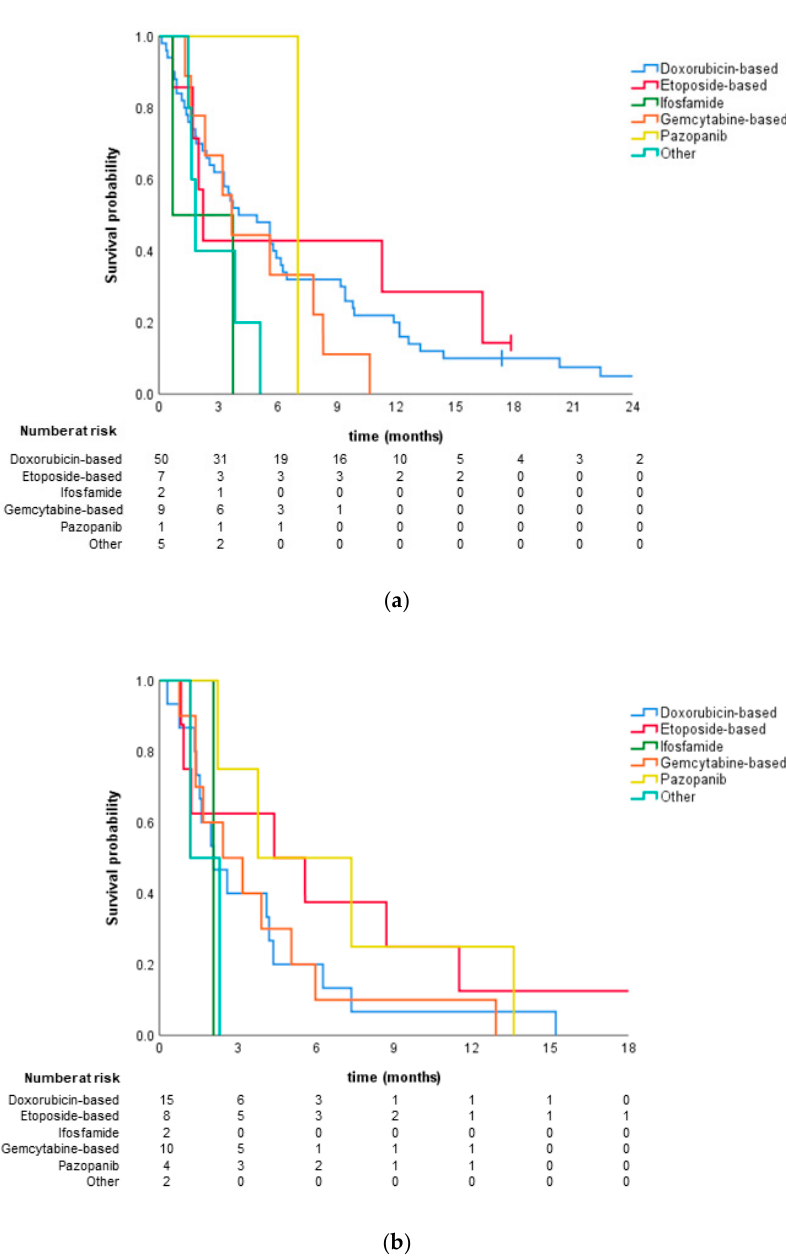
Figure A1. Progression-free survival stratified by chemotherapy regimens used: in the second line of treatment ( a ); and third line of treatment ( b ).